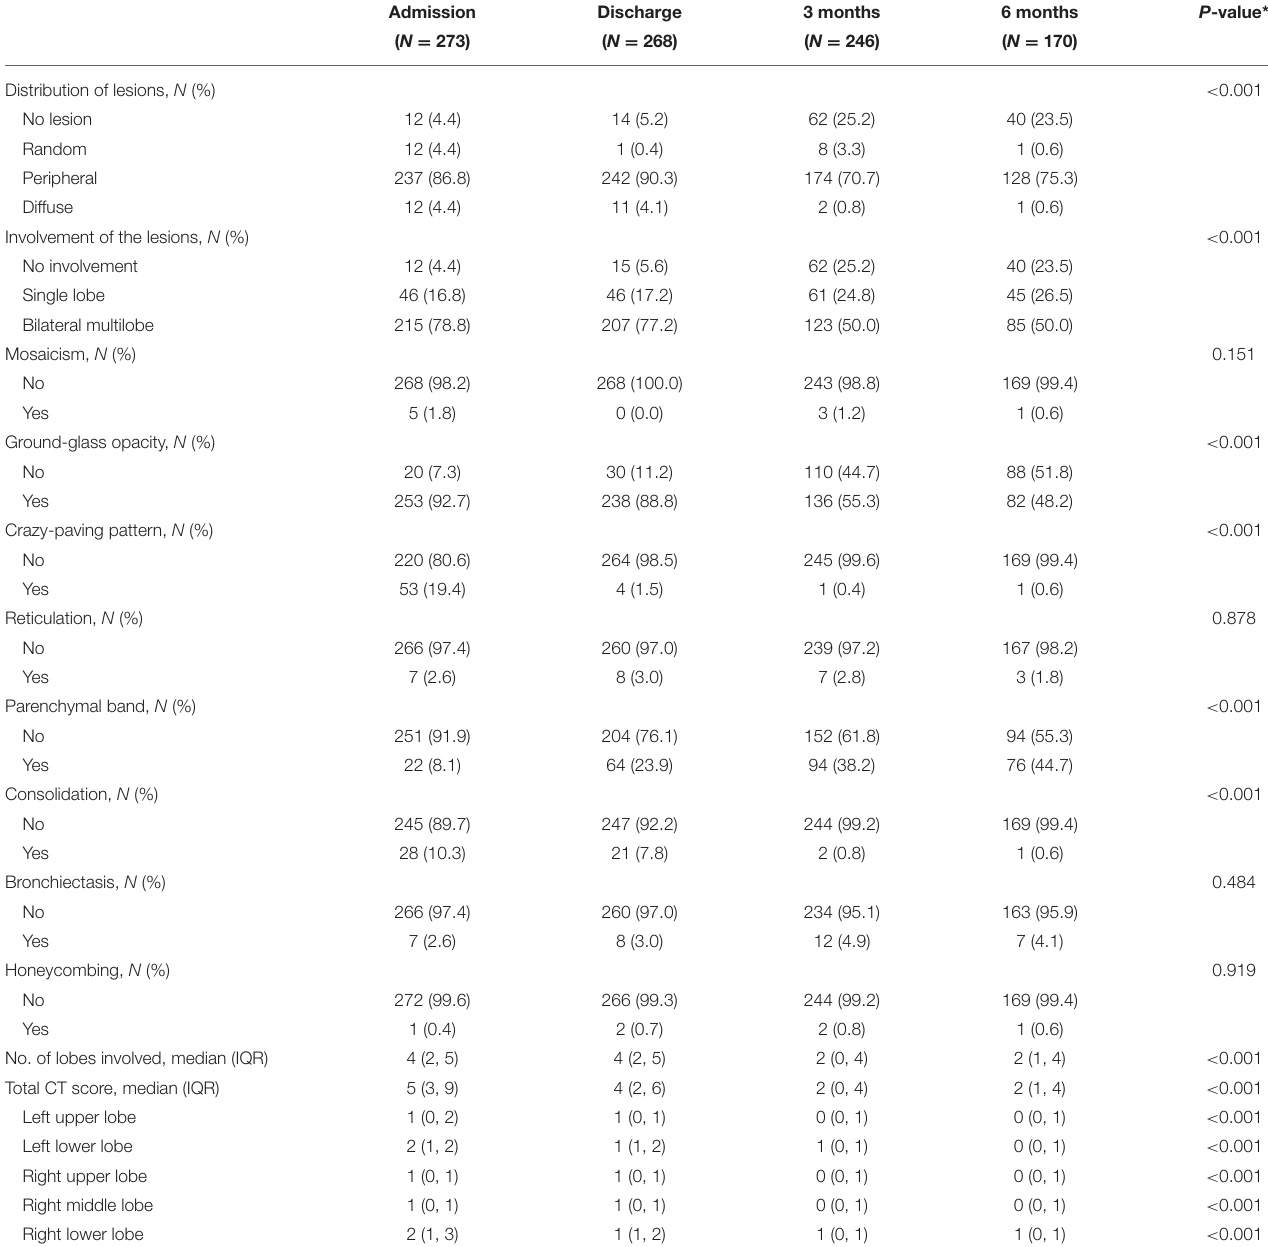
TABLE 2 | Findings of serial CT scans among patients with